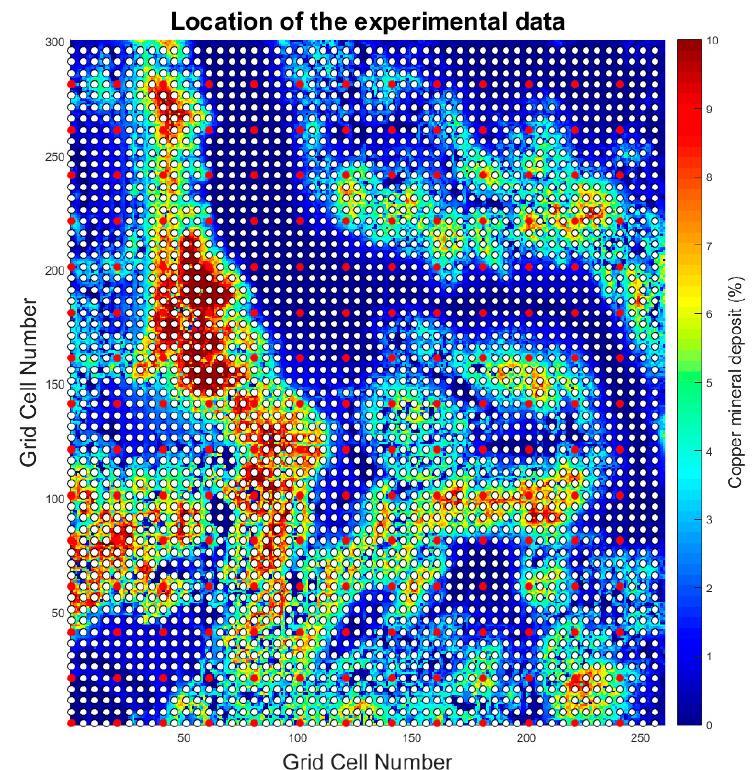
Figure 1. Exhaustive Walker Lake dataset [17] and the experimental data locations used in this work (red filled circles: samples without measurement errors; white filled circles: samples with measurement errors).